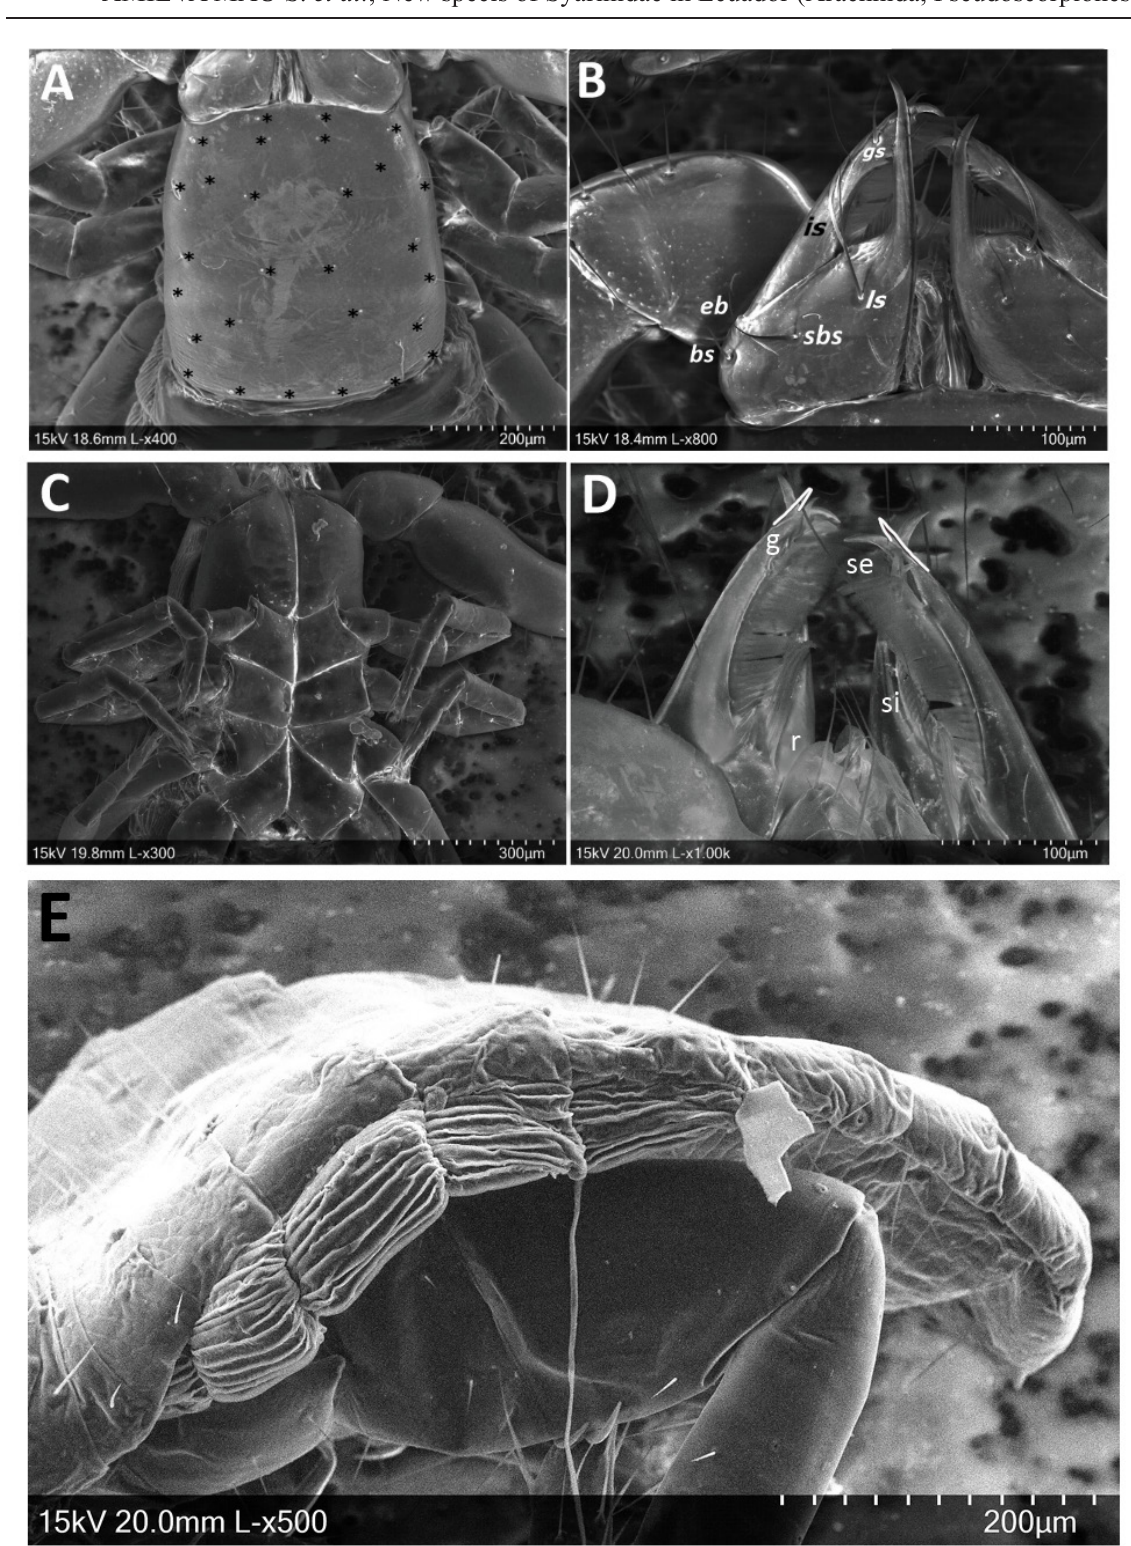
Fig. 27. Scanning electron micrographs of Ideoblothrus safinai sp. nov., ♂♂. A . Carapace with asterisks next to setae. B . Chelicera in dorsal view, with trichobothria. C . Coxa. D . Chelicera in ventral view. E . Longitudinally striate pleural membrane. A–D: paratype (ZMH A0015394); E paratype (ZMH A0015395). Abbreviations: g = galea highlighted; r = rallum; se = serrula exterior; si = serrula